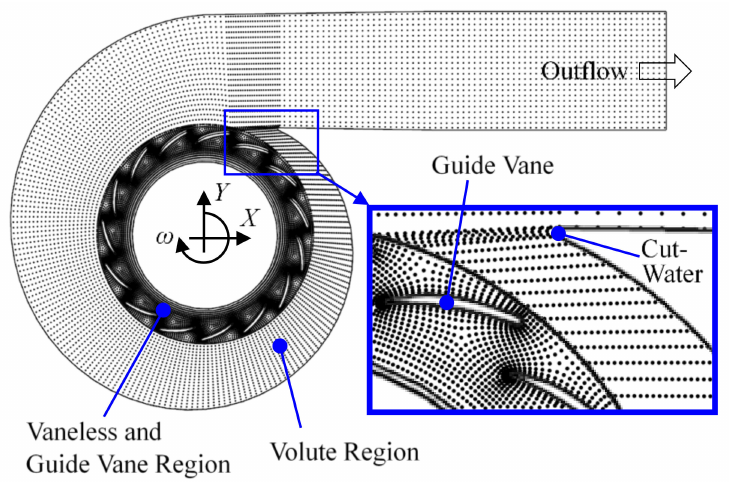
Figure 5. Distribution of PTN in the vaneless region, the vaned diffuser, and the volute on Z = 0